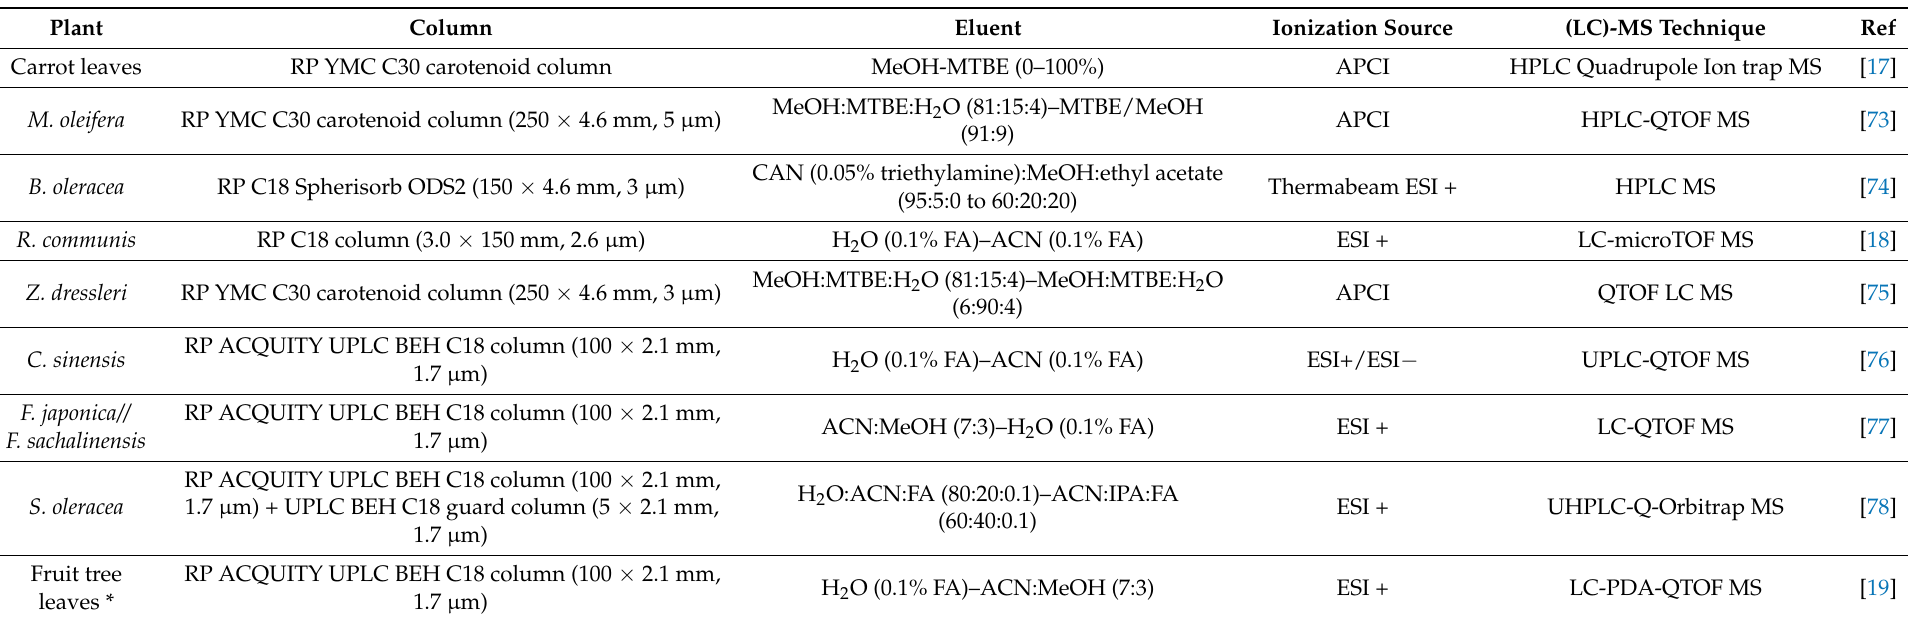
Table 5. Carotenoids—chromatography and mass spectrometry